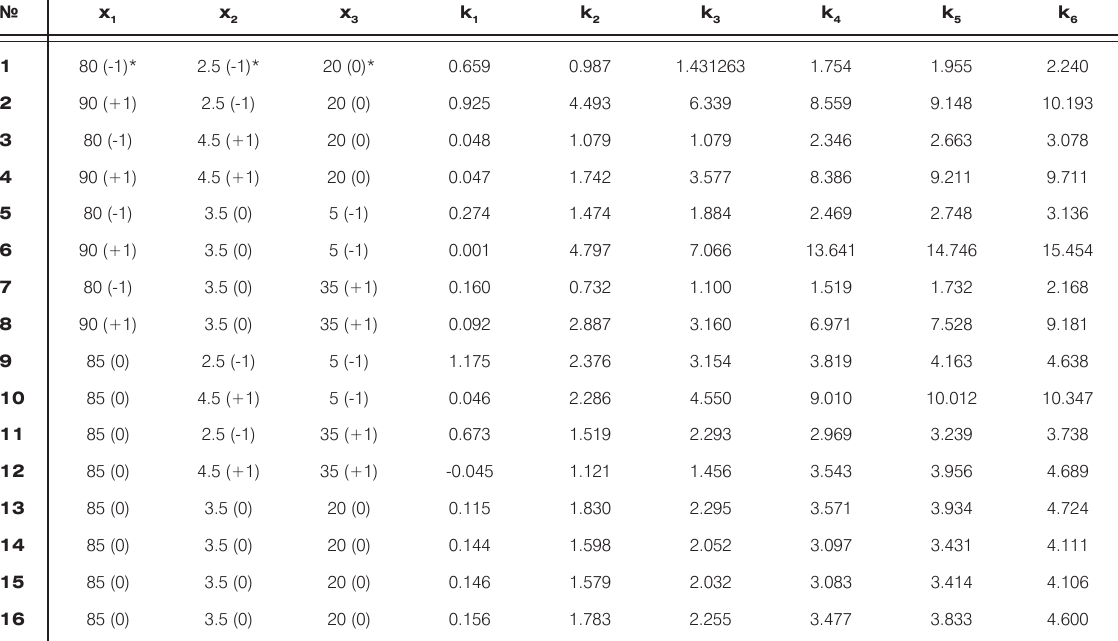
Table 3. Plan of experiments and the obtained